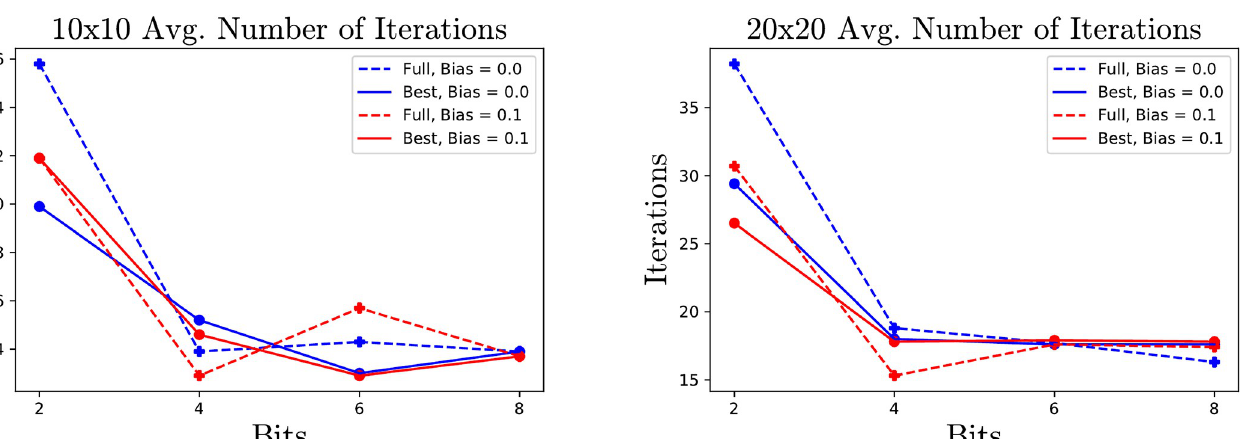
PLOS ONE | https://doi.org/10.1371/journal.pone.0267954 May 9,